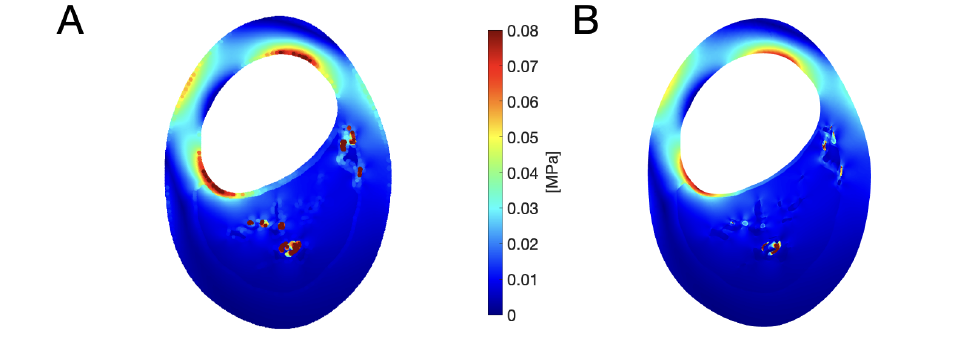
Ω k Von Misses stress distribution k = 1